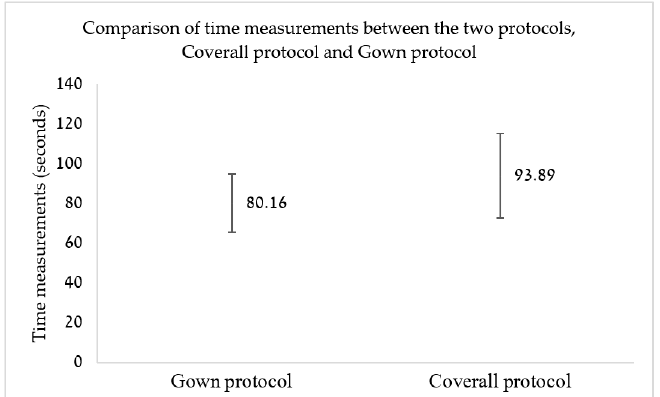
Figure 2. Comparison of center and dispersion indices (mean and standard deviation) between the two protocols examined in the study: coverall protocol and gown protocol.